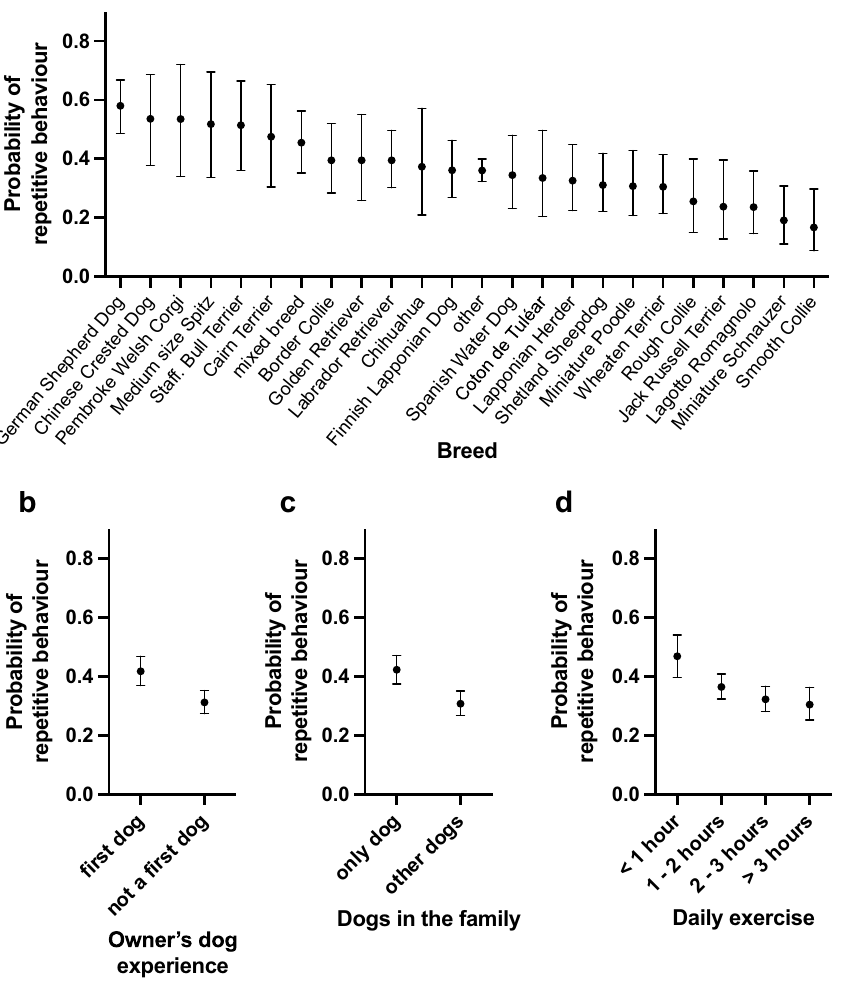
Figure 1. The effects of breed ( a ), owner’s dog experience ( b ), number of dogs in the family ( c ), and daily exercise ( d ) on the probability of repetitive behaviour in the logistic regression analysis. Error bars indicate 95% confidence limits. N =